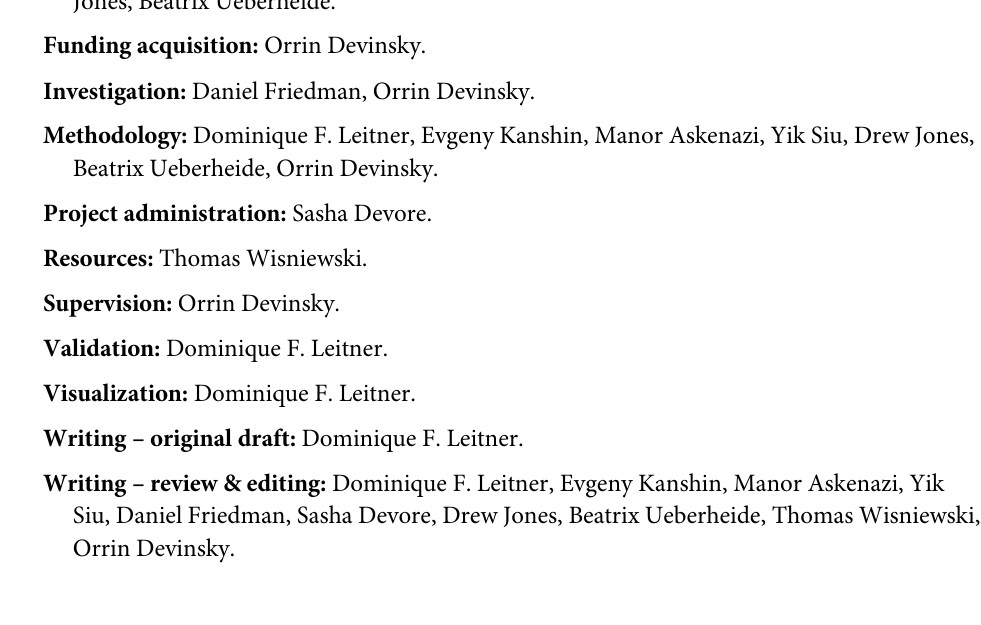
Corresponding ladder for panel A is shown in the colorometric brightfield image. B) On the same blots, actin was evaluated after stripping the phospho-S6 (Ser235/236). B’) Correspond- ing ladder for panel B is shown in the colorometric brightfield image. C) On the same blots, total S6 was evaluated with no stripping (both actin and total S6 are present). C’) Correspond- ing ladder for panel C is shown in the colorometric brightfield image. S2 Raw image. Whole western blot images for phospho-S6 (Ser240/244). A) All cases (n = 14) were evaluated by western blot for phospho-S6 (Ser240/244) quantification on 2 blots, as depicted in Fig 1A. Bands were visualized after ECL on a BioRad ChemiDoc. Quantification was performed on bands in the red outlined box in Fiji ImageJ. One sample (NYUC001) was included on both gels to allow for normalization across blots for all samples. A’) Correspond- ing ladder for panel A is shown in the colorometric brightfield image. B) On the same blots, actin was evaluated after stripping the phospho-S6 (Ser240/244). B’) Corresponding ladder for panel B is shown in the colorometric brightfield image. C) On the same blots, total S6 was eval- uated with no stripping (both actin and total S6 are present). C’) Corresponding ladder for panel C is shown in the colorometric brightfield